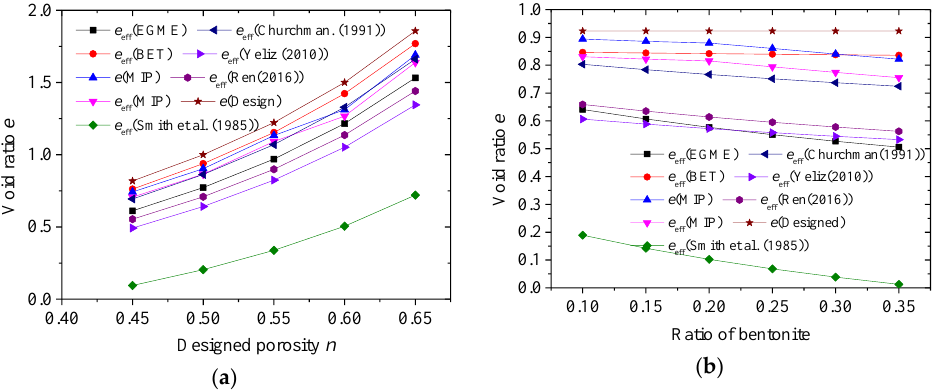
Figure 8. The e of two types soil samples: ( a ) S type soil samples; ( b ) Y type soil samples [7,63,74,75].